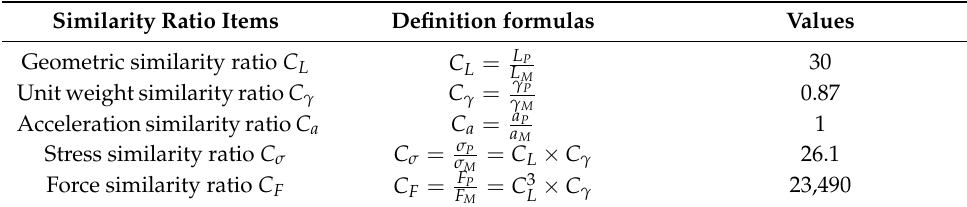
Table 4. Similarity